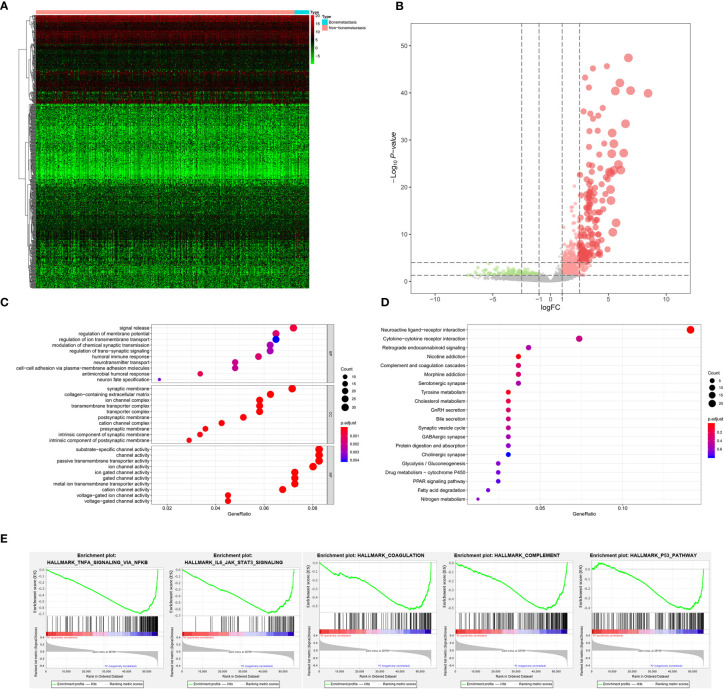
The results of differential expression genes analysis and functional enrichment analysis between BLCAs with and without bone metastasis: The heatmap (A) and volcano plot (B) of the differential expressed genes. The GO (C), KEGG (D), and (E) top five GSEA enriched terms for the differential expressed genes.